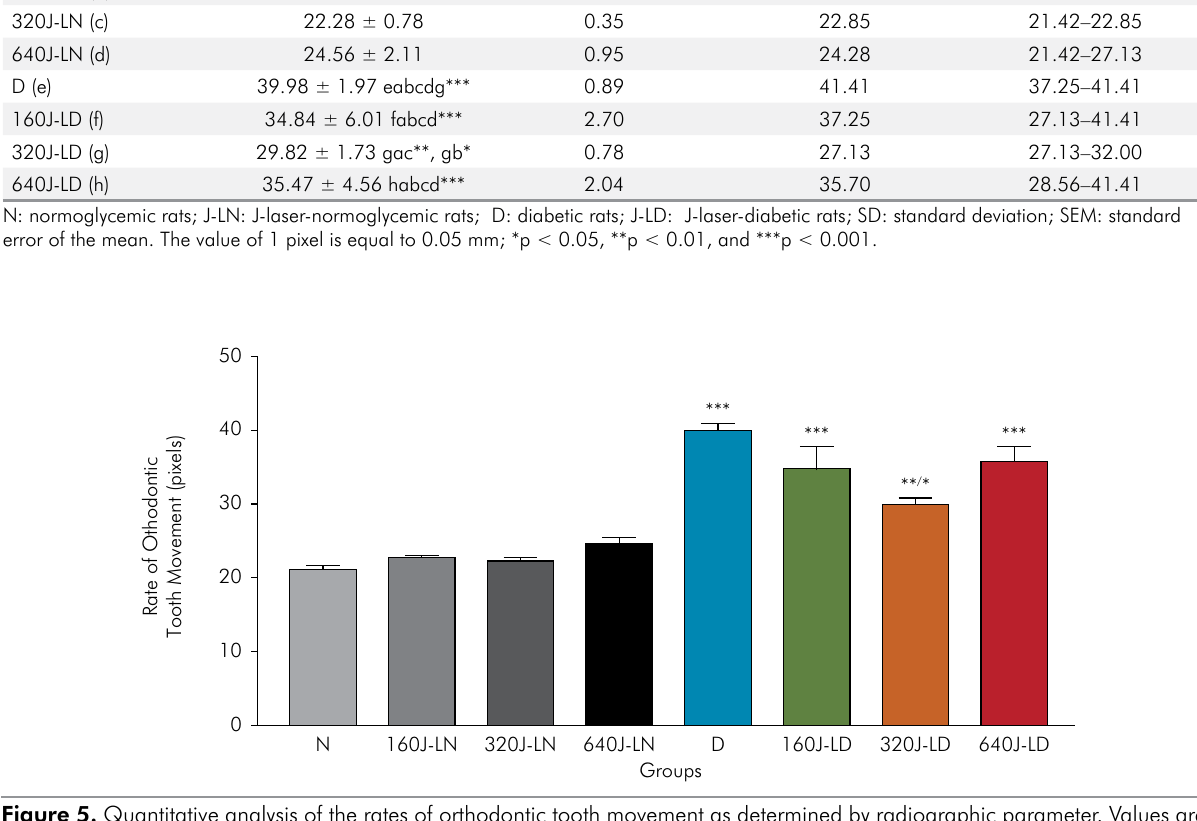
Figure 5. Quantitative analysis of the rates of orthodontic tooth movement as determined by radiographic parameter. Values are expressed as mean ± standard